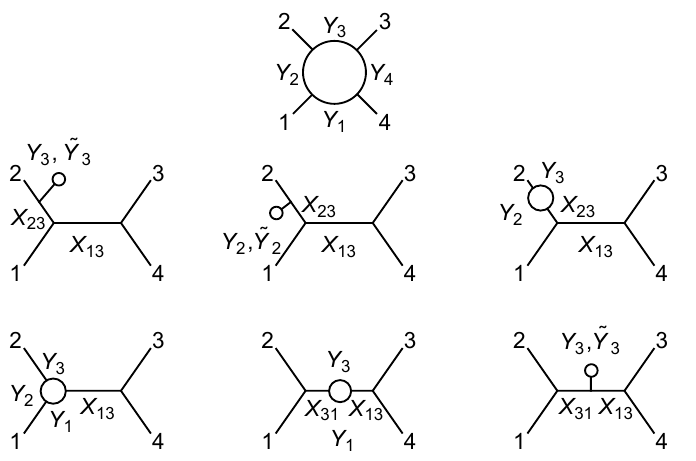
Figure 16 . A kinematic spacetime region for D 4 .